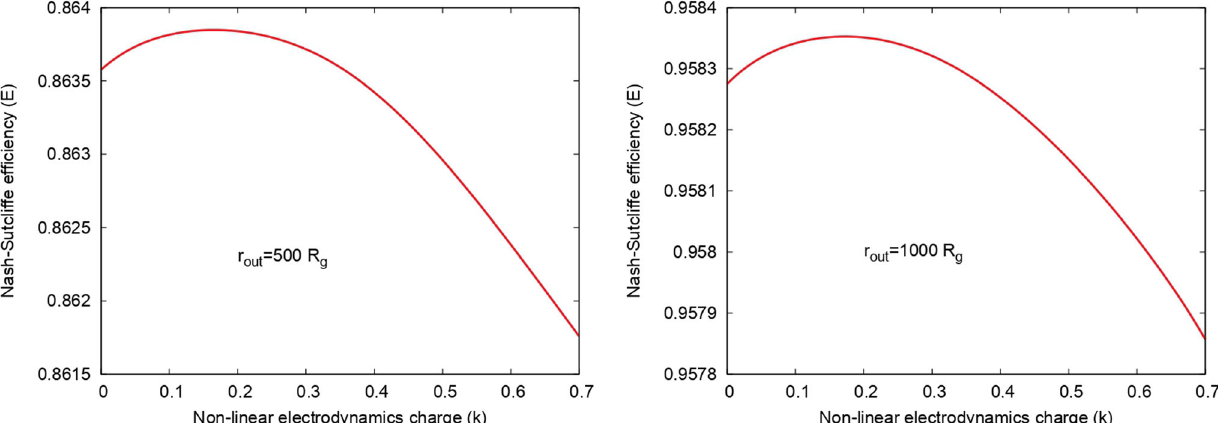
Fig. 3 The above figure illustrates the variation of the Nash–Sutcliffe Efficiency E with the non-linear electrodynamics charge parameter k . In the left panel the theoretical optical luminosity is computed with r out = 500 r g while the right panel corresponds to r out = 1000 r g for